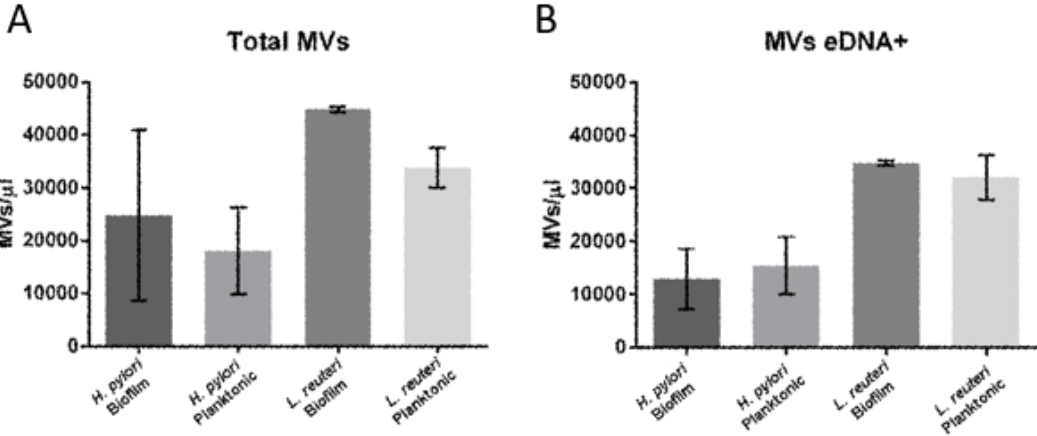
Figure 4. Numbers of EVs. Box plots represent absolute numbers of total EVs ( A ) and MVs containing eDNA ( B ) isolated from the planktonic and the biofilm phenotypes of H. pylori and L. reuteri . ( A ) Figures are representative of three independent experiments.